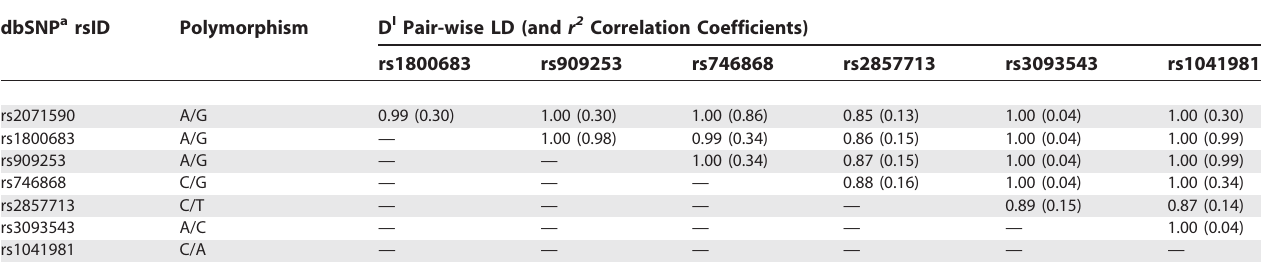
Table 3. Pair-Wise Standardised Disequilibrium (D I ) and Correlation (r 2 ) Coefficients, between Individual SNPs for the LTA Gene dbSNP a rsID